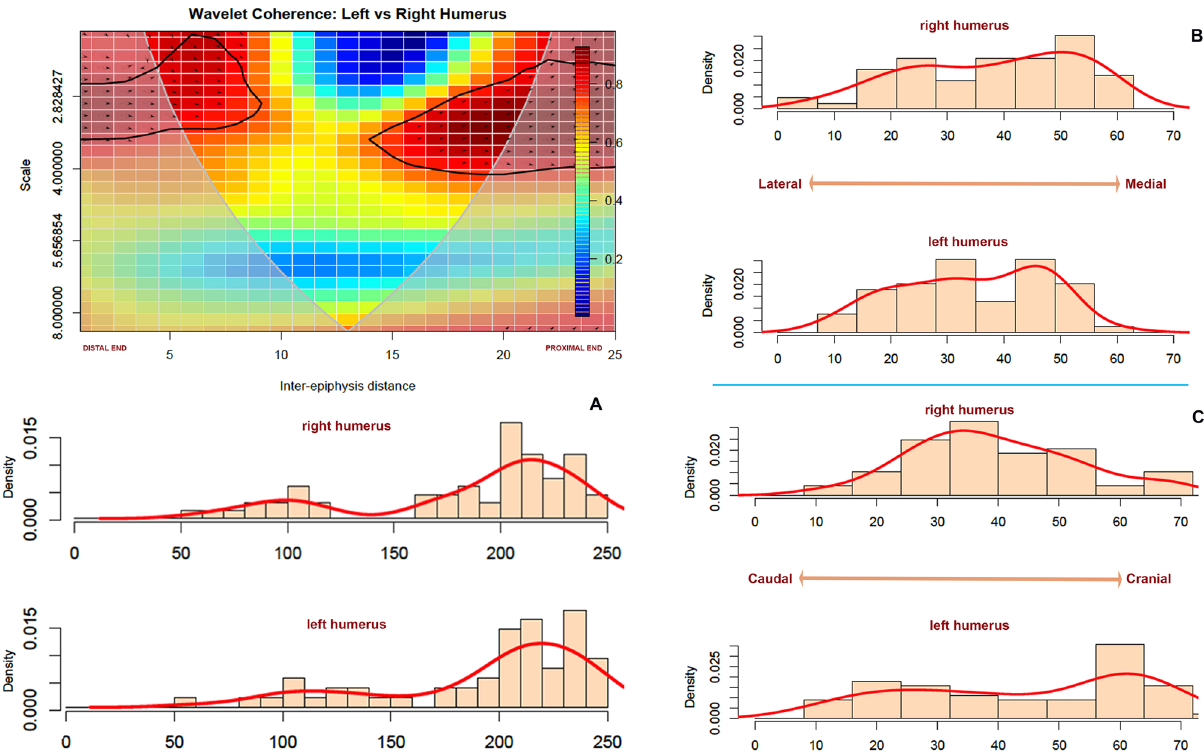
Figure 5. Bivariate wavelet coherence plot showing the correlation of most tooth mark damage on the proximal and distal sections of left and right humeri in low frequencies. Arrows indicate that in these two high- correlation areas, both humeral sides are in phase (i.e., the covary together in the same direction). In the distal area, the right humerus is leading (arrows pointing to the right-down or left-up) and in the proximal area, the left humerus leads (arrows pointing to the right-up or left-down). Binning of histograms is described in Table 3. ( A ) frequency of marks from distal end (left) to proximal (right) end; ( B ) frequency of marks from lateral (left) to medial (right), and, ( C ) frequency of marks on caudal (left) to cranial (right).